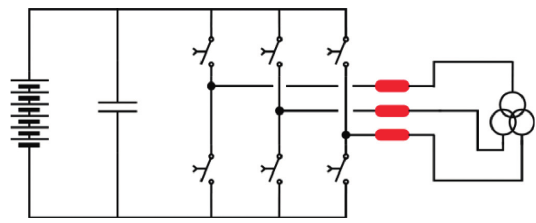
Figure 1: Traction inverter’s three-phase output current sensing location.